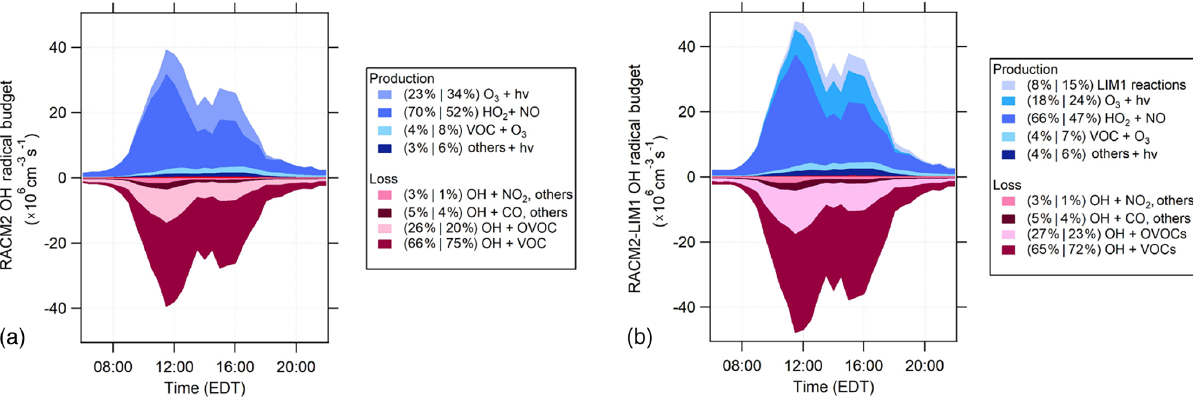
Figure 10. RACM2 (a) and RACM2-LIM1 (b) OH radical budgets for the days with NO measurements. Shades of blue represent production reactions, and the shades of red represent loss rates. The percent contribution of each reaction to total production or loss is divided into two periods (10:00 to 14:00EDT and 14:00 to 18:00EDT). The “Others + hν ” category includes the photolysis of HONO, H 2 O 2 , organic peroxides, and HNO 3 (see